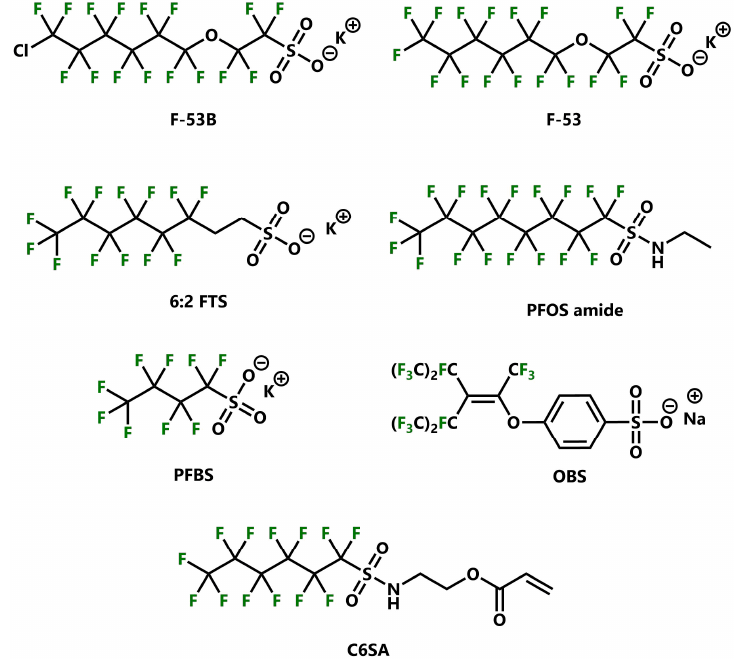
Figure 3. Overview of selected PFASs derivatives activated in tribochemical reactions. First row left: chemical structure of monosubstituted 2-[(6-chloro-1,1,2,2,3,3,4,4,5,5,6,6-dodecafluorohexyl)oxy]-1,1,2,2-tetrafluorethane sulfonate potassium salt know as F-53B. First row right: chemical structure of 2-[(1,1,2,2,3,3,4,4,5,5,6,6,6-tridecafluorohexyl)oxy]-1,1,2,2-tetrafluoroethane sulfonate potassium salt, abbreviated as F-53. Second row left: chemical structure of 1H,1H,2H,2H-perfluorooctanesulfonate potassium salt, short 6:2-FTS. Second row right: chemical structure of N-ethylperfluorooctane-1- sulfonamide (PFOS amide). Third row left: Structure of perfluorobutyl sulfonate potassium salt (PFBS). Third row right: chemical structure of p -perfluorous nonenoxybenzene sulfonate sodium salt (OBS). Bottom: chemical structure of 2-[2-(perfluorohexyl)]-sulfonylmethylaminoethyl acrylate, C6SA.